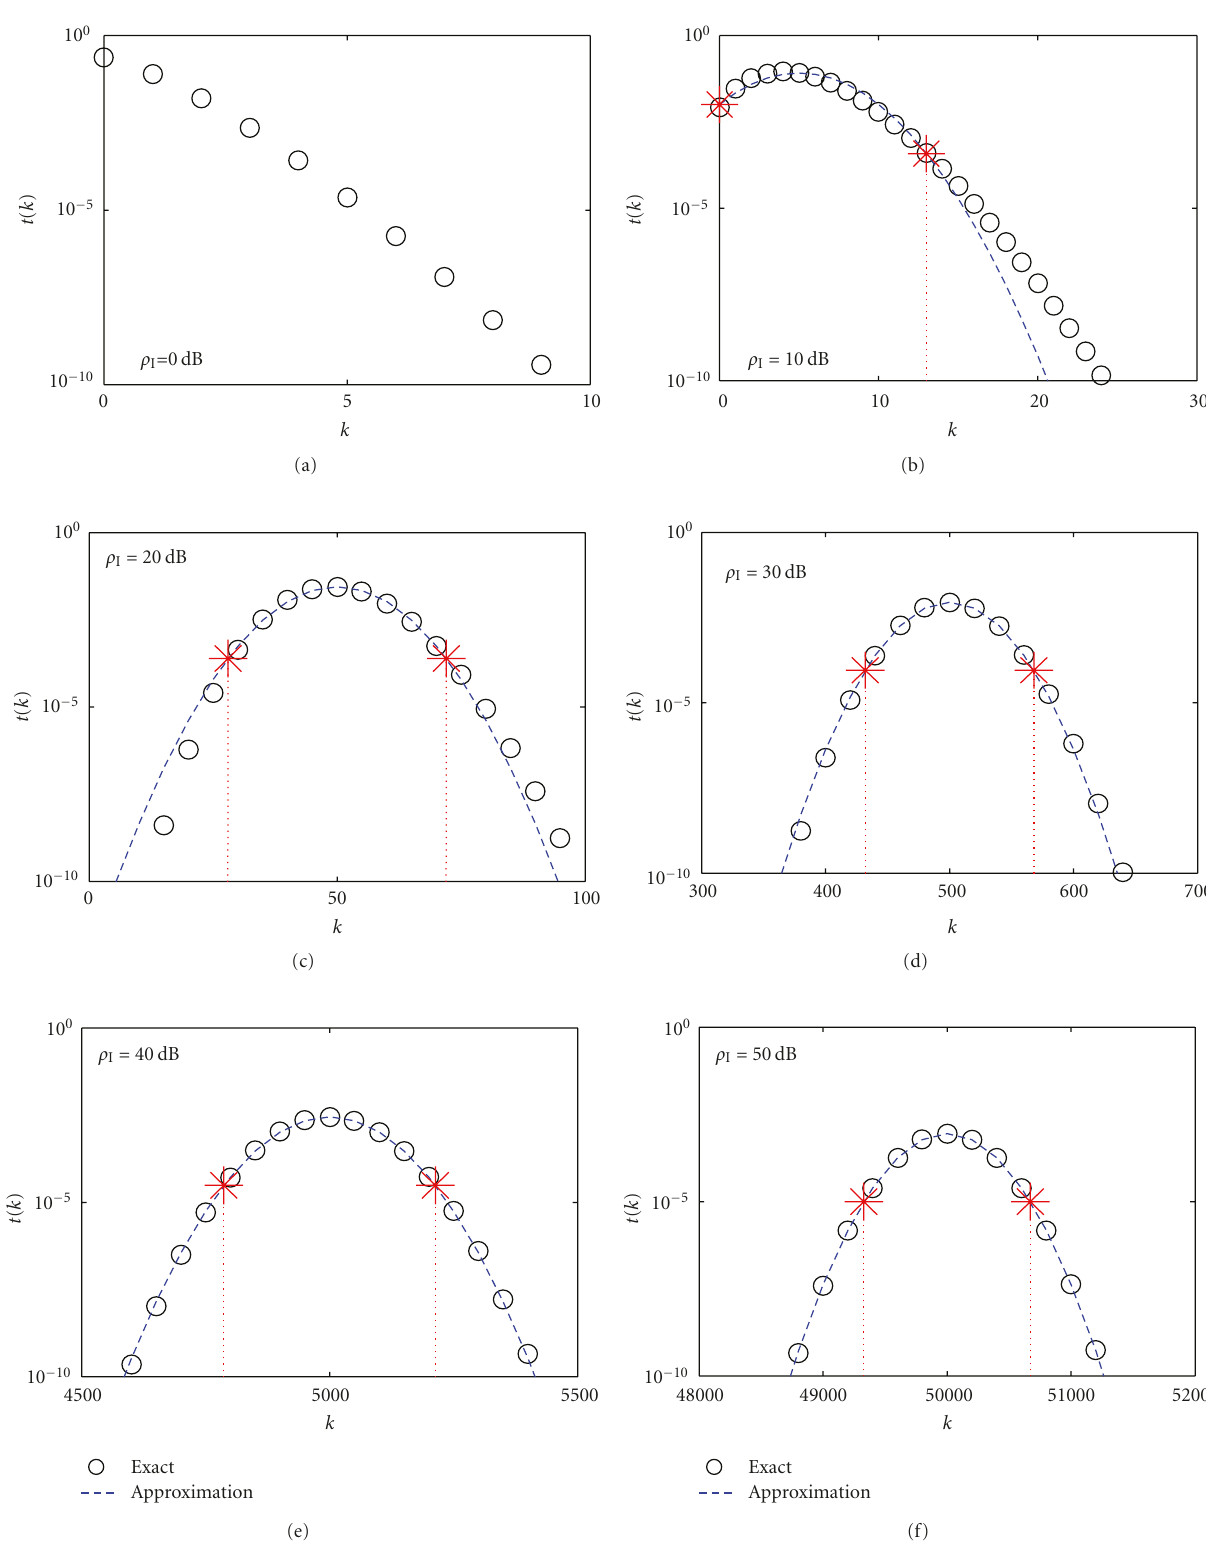
Figure 3: Evaluation of t ( k ) when ρ N = 30 dB. Comparison between the exact value in (12) and the approximation in (14). The asterisks denote k min and k max obtained for T =